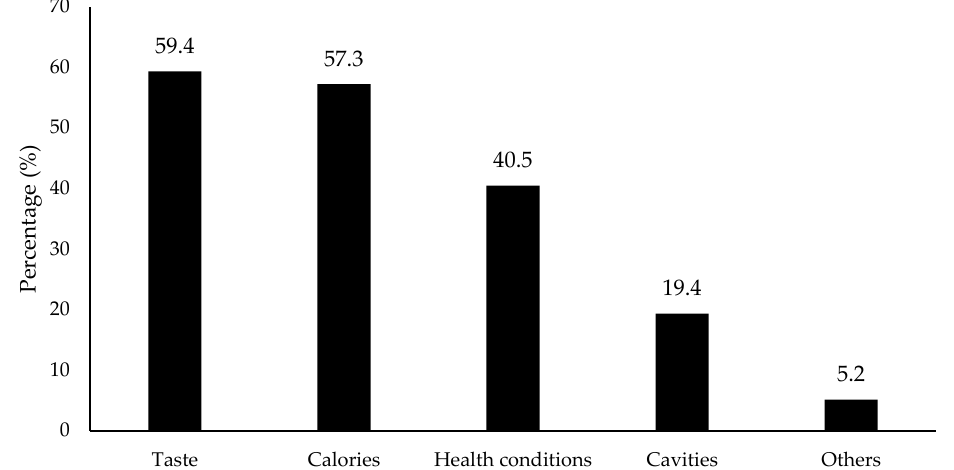
Figure 8. Percentage (%) for the factors that consumers thought were the most important when they chose sugar-reduced products (N = 901). Others included alternative sweeteners, natural ingredi- ents (artificial sweeteners), and carbohydrates according to the collected data.